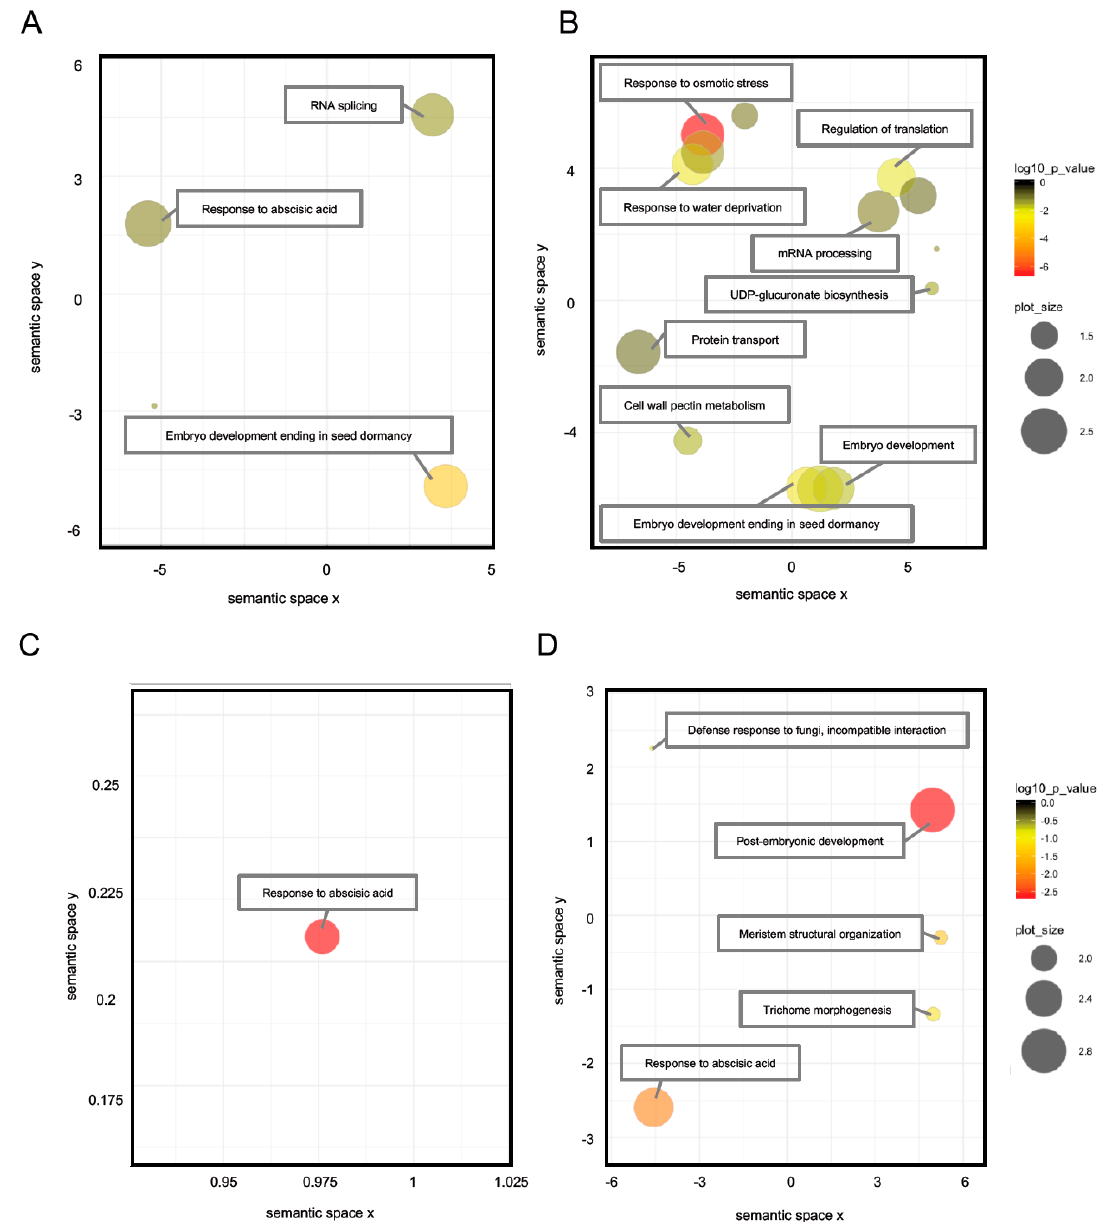
Figure 4. GO analysis of phosphopeptides in barley seeds. GO terms were evaluated by DAVID program and visualized with REViGO for phosphopeptides upregulated and downregulated under imbibition. Each circle color and size show p -value and frequency (%), respectively. Phosphopeptides used for this analysis included 70 and 171 phosphopeptides upregulated in FH ( A ) and AR ( B ) seeds, respectively; 38 and 58 phosphopeptides downregulated in FH ( C ) and AR ( D ) seeds, respectively.